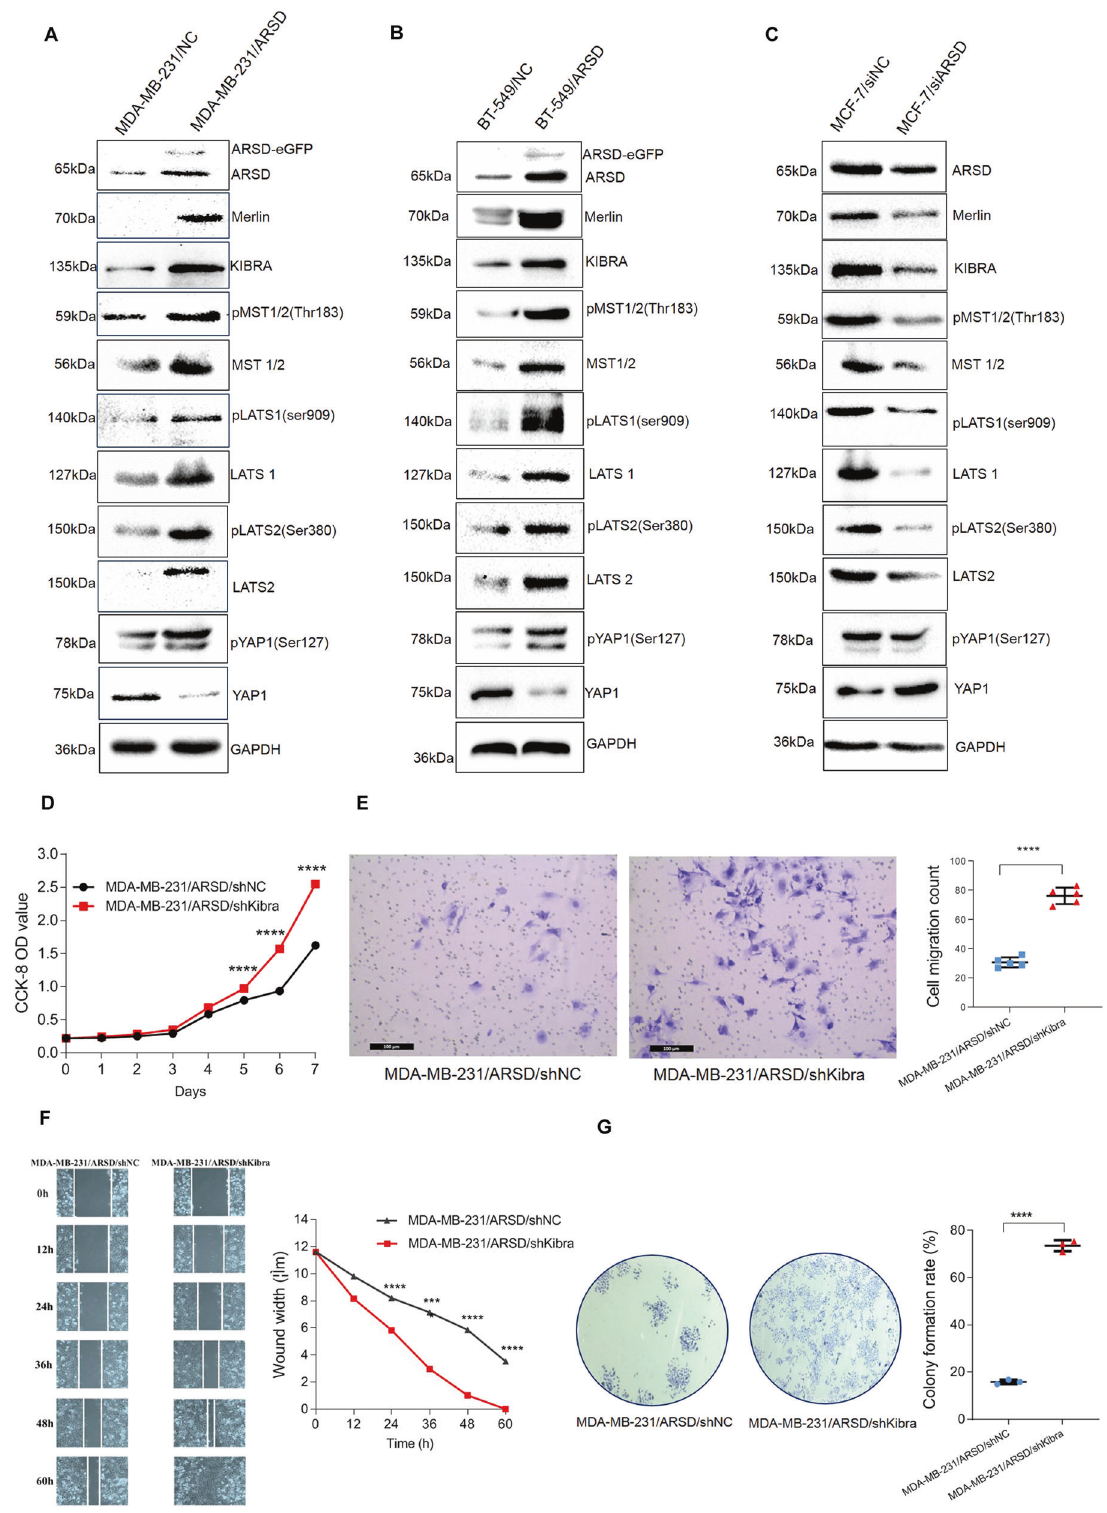
Fig. 6 Ectopic ARSD overexpression activates Hippo/YAP pathway in breast cancer cells. A , B Western blotting veri fi es that ARSD overexpression activates Hippo/YAP pathway in MDA-MB-231 and BT-549 cells. C ARSD knocking down inactivates Hippo/YAP pathway in MCF-7 cells. All molecular weights are in KDa. All experiments were repeated three times independently, yielding similar results, representative images are shown. D Cell proliferation analysis of negative control (MDA-MB-231/ARSD/shNC cells) and MDA-MB-231/ARSD/ shKibra cells is detected every 24 h after plating (day 0) by using CCK-8 assay. E Transwell assay of MDA-MB-231/ARSD/shNC cells and MDA- MB-231/ARSD/shKibra cells. F Wound healing assay of MDA-MB-231/ARSD/shNC cells and MDA-MB-231/ARSD/shKibra cells. G Colony formation of MDA-MB-231/ARSD/shNC cells and MDA-MB-231/ARSD/shKibra cells on a plastic substrate. The colony formation rate was quanti fi ed using ImageJ software 14 days after plating; error bars are ±SEM (* p < 0.05, ** p < 0.01, *** p < 0.001). Cell Death and Disease (2021)